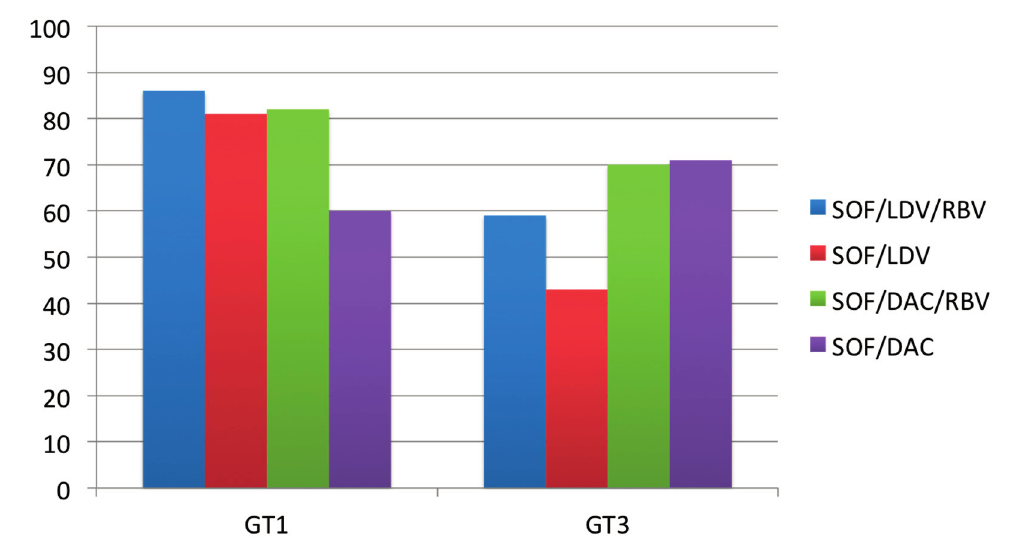
Figure 1. Adapted from Foster GR et al. [38]: Intention to treat analysis with SVR12 by genotype and therapy